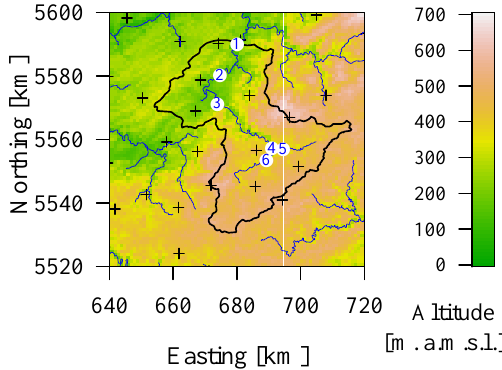
Figure 2. Topographic map of the Upper Ourthe (black line) includ- ing the river network (blue lines), rain gauges (crosses), six river gauges (white circles labelled with numbers: 1 – Tabreux, 2 – Dur- buy, 3 – Hotton, 4 – Nisramont, 5 – Mabompré, and 6 – Ortho). Projection is in the Universal Transverse Mercator (UTM) 31N co- ordinate system. After Rakovec et al.